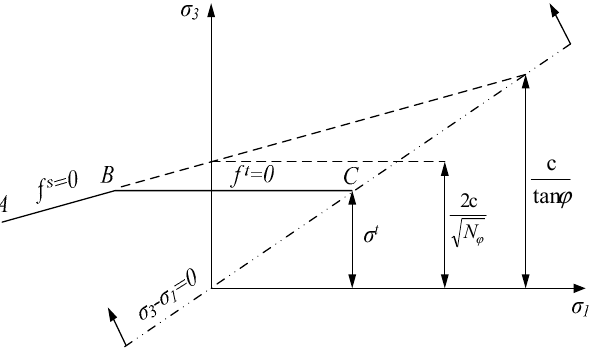
Figure 6. Mohr–Coulomb failure criterion for block in UDEC [60].